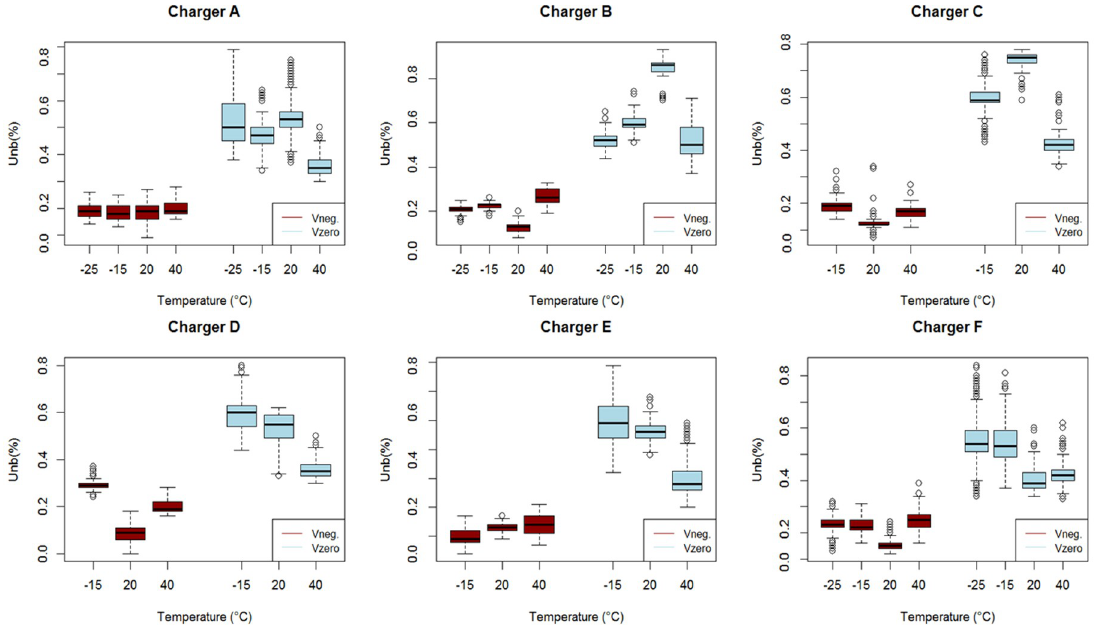
Figure 6. Boxplots of unbalances, presented by voltage negative sequence (red) and zero sequence (blue) of each charger, per temperature level measured.